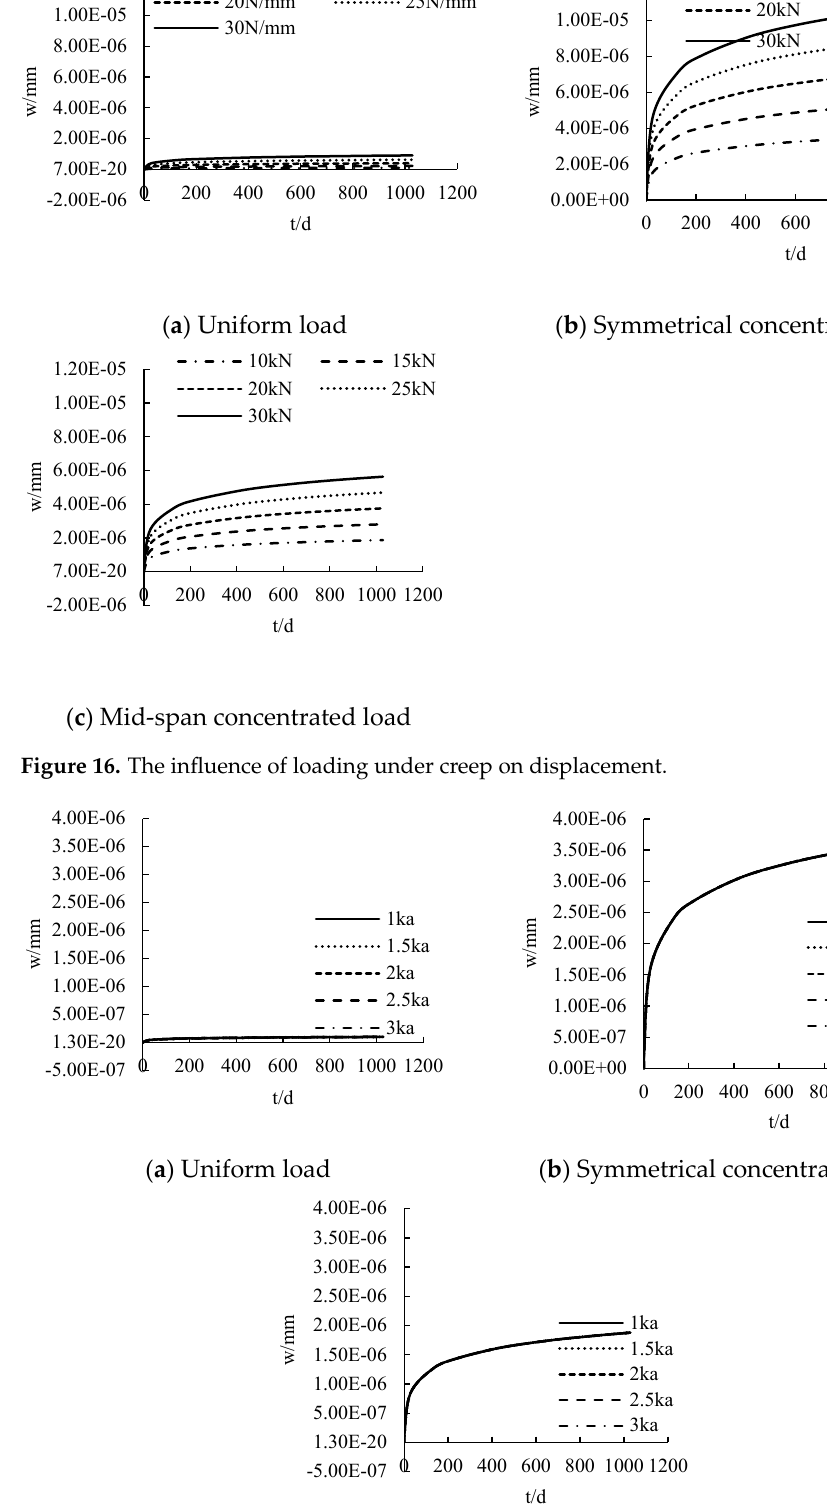
( c ) Mid-span concentrated load Figure 17. The influence of adhesive layer stiffness under creep on displacement. 5. Conclusions